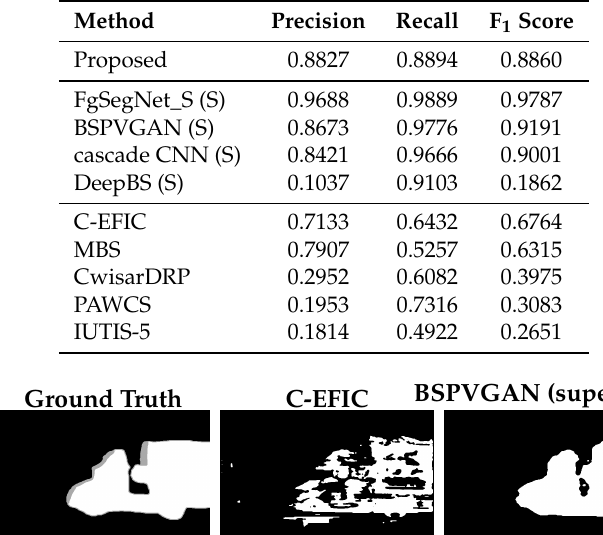
Table 2. Comparison of Precision, Recall and F 1 scores obtained by the proposed method and state-of-the-art methods on the ’continuousPan’ sequence of the public ChangeDetection.NET 2014 dataset. These scores were obtained with the software provided by the creators of the dataset. Supervised methods are denoted with an ‘S’. Links to other methods can be found on the ChangeDetection.NET website ([22]).